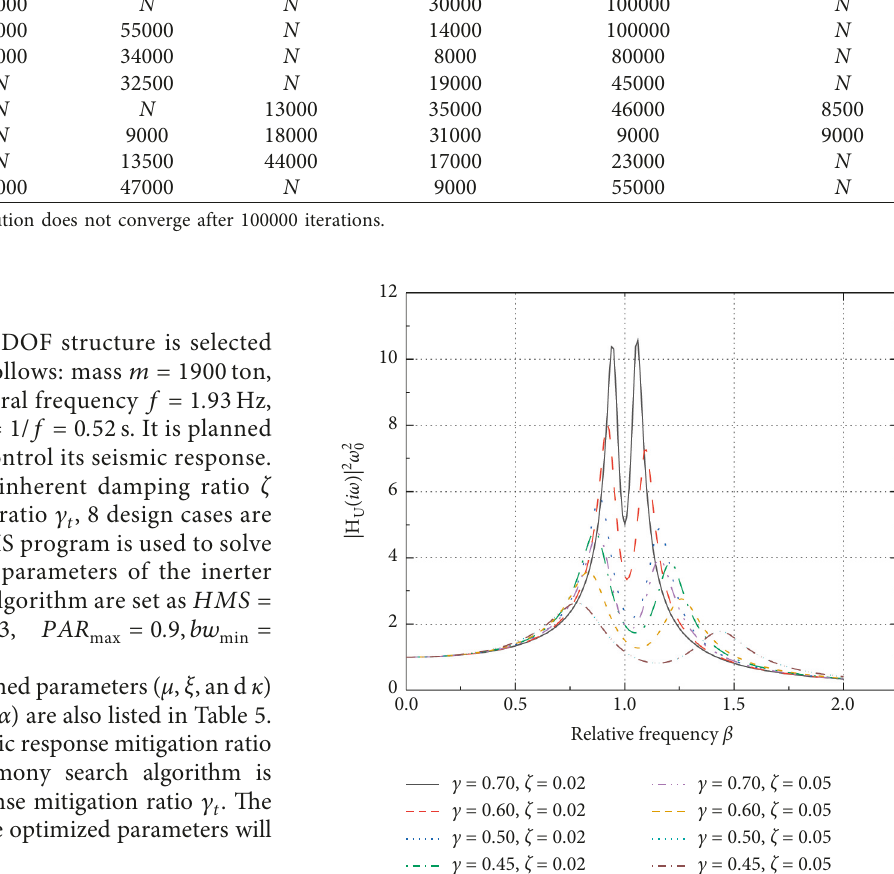
Figure 14: Frequency-domain displacement transfer function curves of SDOF structure with the inerter